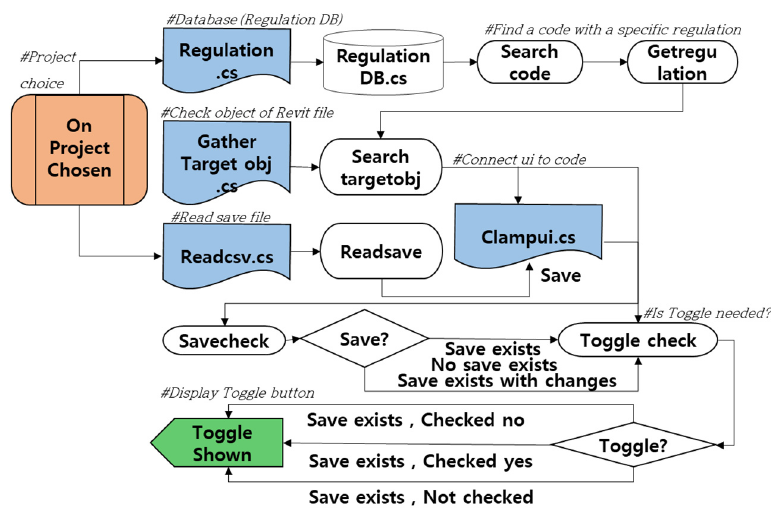
Figure 8. Algorithm to connect design checklist.